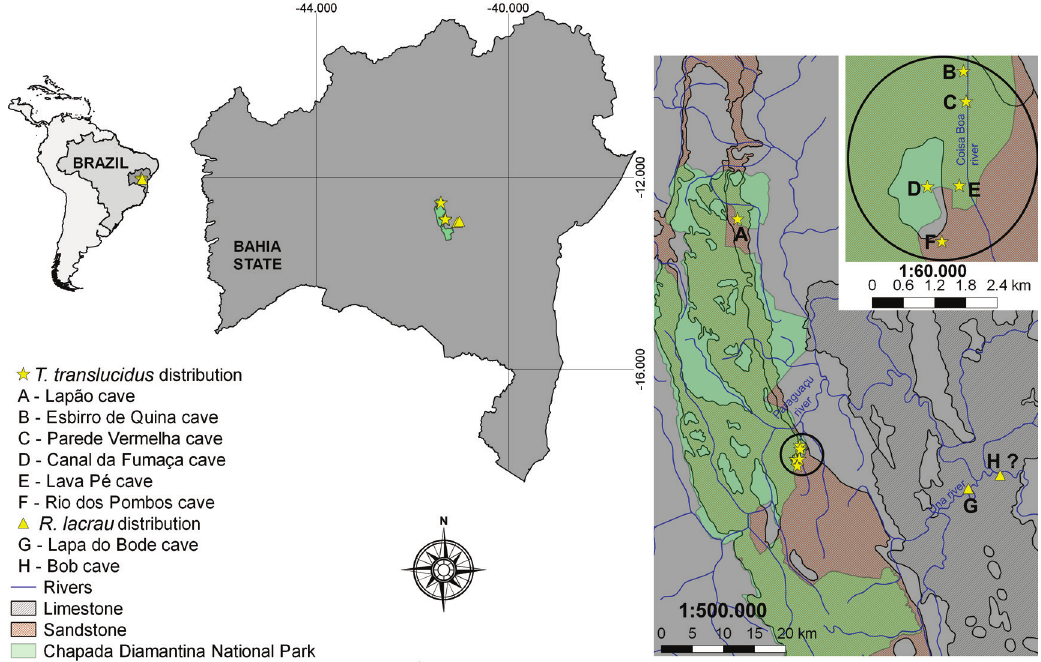
Figure 1. Distribution of Troglorhopalurus translucidus and Rhopalurus lacrau with type-locality and new records for both species. Question mark (?) indicates a new possible record in cave for R. lacrau , see text for